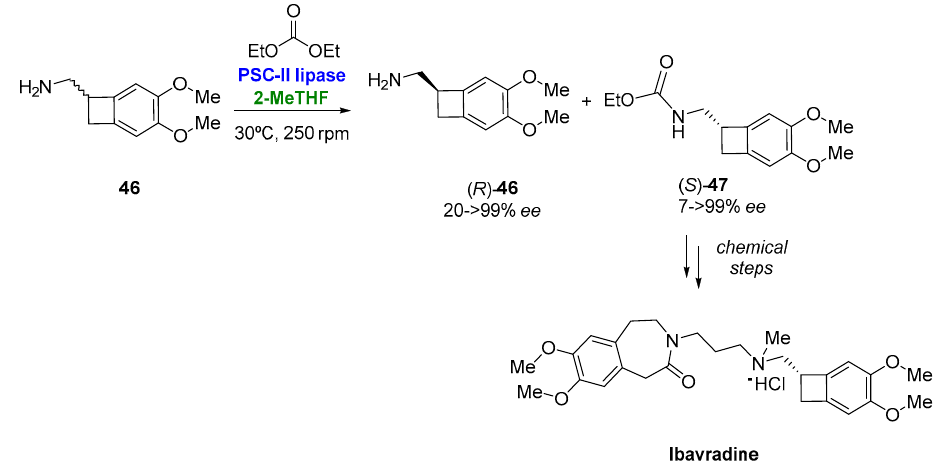
Figure 24. Chemoenzymatic preparation of optically pure Ivabradine.